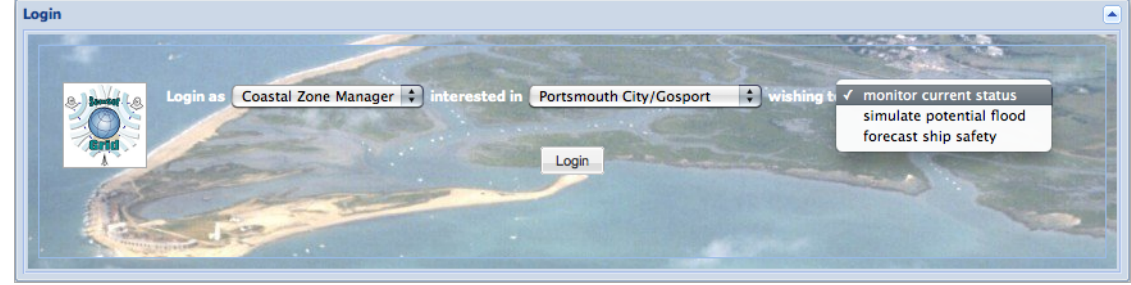
Figure 8. Screenshot of the login screen for the web application.